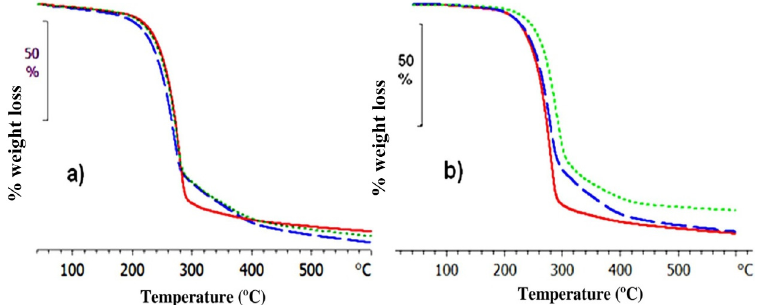
Figure 2. Thermogravimetric results, % weight loss as a function of temperature of the samples PEI2000-PLA20 (continuous line), PEI2000-PLA5 (dashed line) and PEI800-PLA5 (dotted line): ( a ) original samples; ( b ) isothermally preconditioned samples.